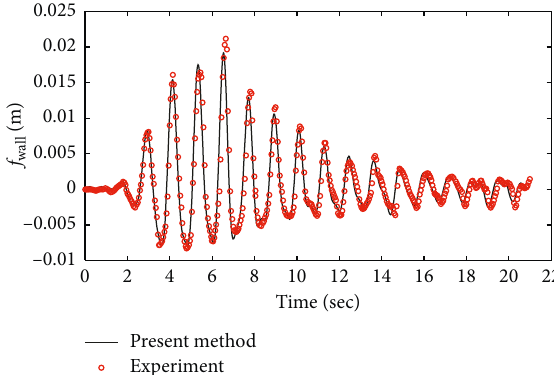
Figure 10: Time history of the surface wave height on the wall at θ � 0 subjected to Tabas earthquake (Iran,